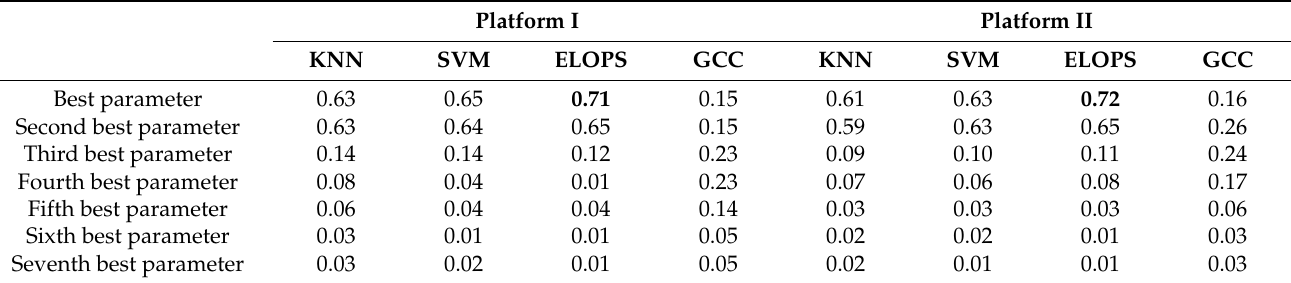
Table 6. Prediction accuracy on the different platforms.